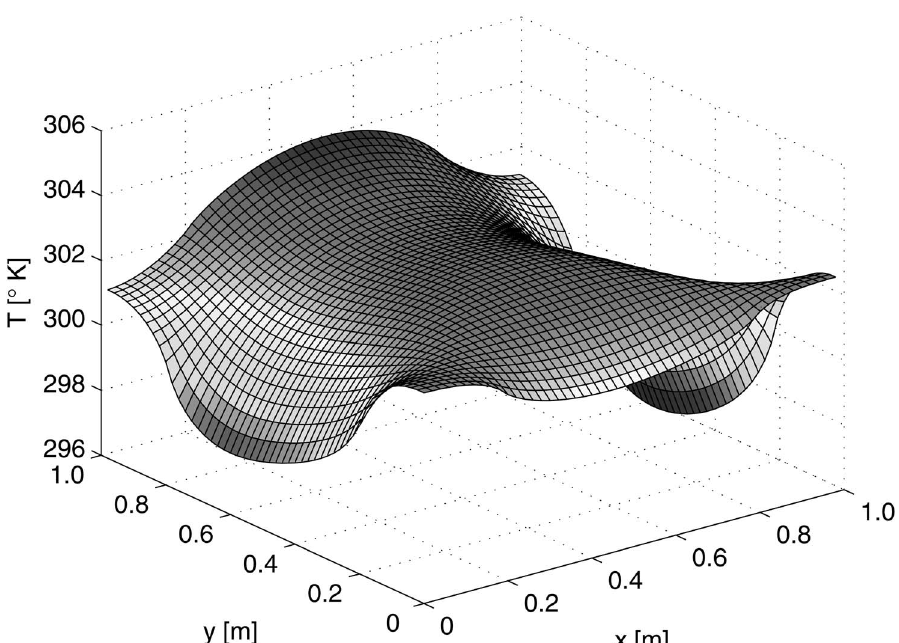
Figure 4. Steady-state temperature, after 20